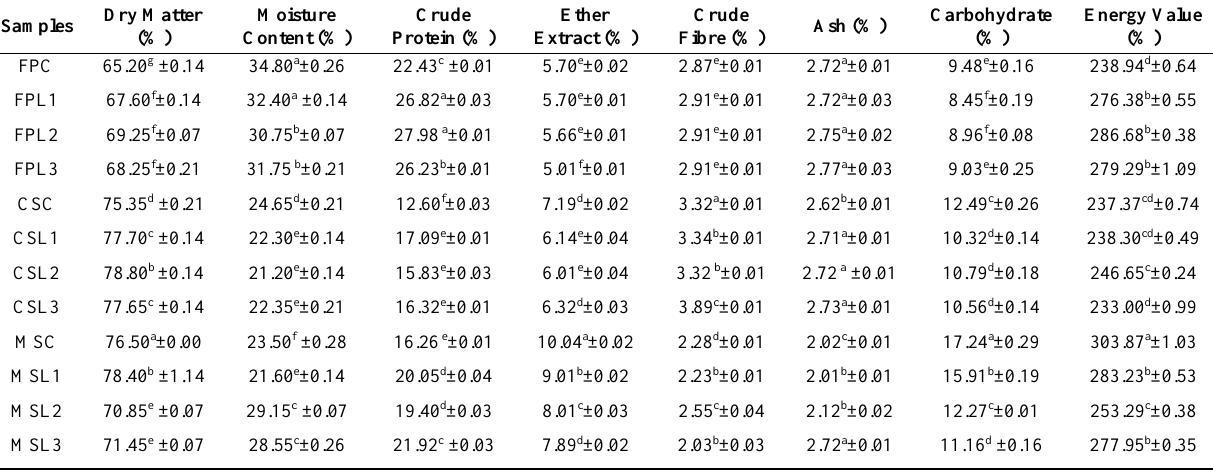
Values are means of replicate determinations. Means with different superscripts across columns are significantly different ( p < 0.05); FPC, ogiri from fluted pumpkin seeds; FPL1, ogiri from fluted pumpkin seeds inoculated with Lactobacillus acidophilus ; FPL2, ogiri from fluted pumpkin seeds inoculated with L. fermentum ; FPL3, ogiri from fluted pumpkin seeds inoculated with mixed cultures of L. acidophilus and L. fermentum ; CSL1, ogiri from castor seeds inoculated with L. acidophilus ; CSL2, ogiri from castor seeds inoculated with L. fermentum ; CSL3, ogiri from castor seeds inoculated with mixed cultures of L. acidophilus and L. fermentum ; MSL1, ogiri from melon seeds inoculated with L. acidophilus ; MSL2, ogiri from melon seeds inoculated with L. fermentum ; MSL3, ogiri from melon seeds inoculated with mixed cultures of L. acidophilus and L.